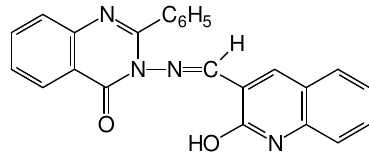
Figure 1 . Structure of HQMAPQ ligand